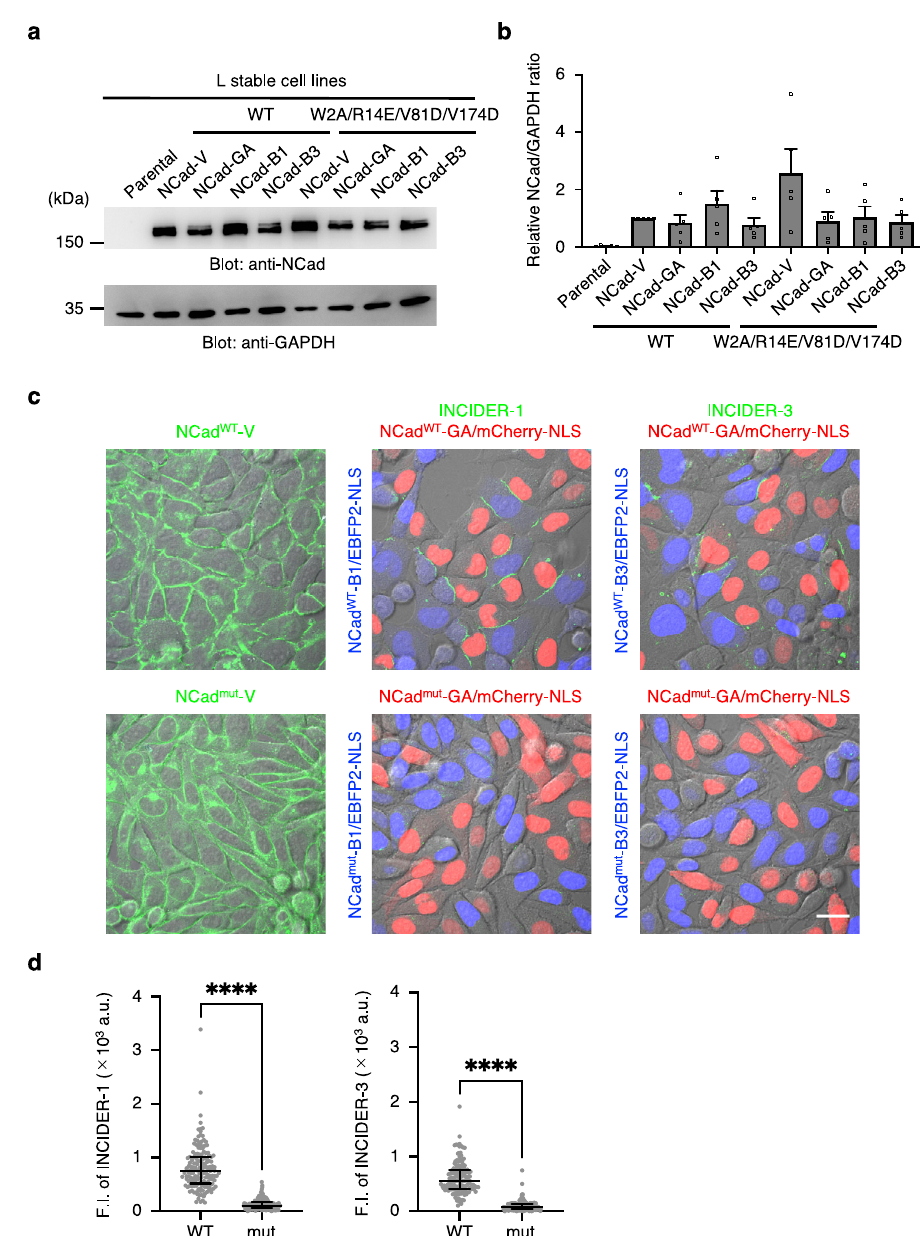
Fig. 3 NCad-mediated cell – cell interactions visualized by INCIDERs. a Examination of NCad expression in stable cell lines. Lysates prepared from parental L cells and L cells stably expressing the indicated NCad constructs were subjected to SDS-PAGE, followed by western blot analysis using the indicated antibodies. b Relative protein expression levels were estimated among cell lines as NCad/GAPDH ratio based on western blot analysis data. Both upper and lower bands of NCad were used for the quanti fi cation. NCad/GAPDH ratios were normalized by that of NCad WT -V. Data are presented as relative mean values ± SEM. Five independent experiments were performed. c The localization of NCad WT -V and NCad mut -V in stable cell lines. Co-culture experiments of cells individually expressing the NCad WT -GA/NCad WT -B1 pair (INCIDER-1), NCad WT -GA/NCad WT -B3 pair (INCIDER-3), NCad mut -GA/ NCad mut -B1 pair, and NCad mut -GA/NCad mut -B3 pair. Scale bar, 20 μ m. d Wild-type (WT) and mutant (mut) INCIDERs ’ fl uorescent signals at cell – cell contact sites were quanti fi ed and compared. Data are presented as lower quartile (lower whisker), median (center line), and upper quartile (upper whisker). Signi fi cant differences were analyzed by Mann – Whitney U test. **** p < 0.0001. 166 (WT of INCIDER-1), 156 (mut of INCIDER-1), 139 (WT